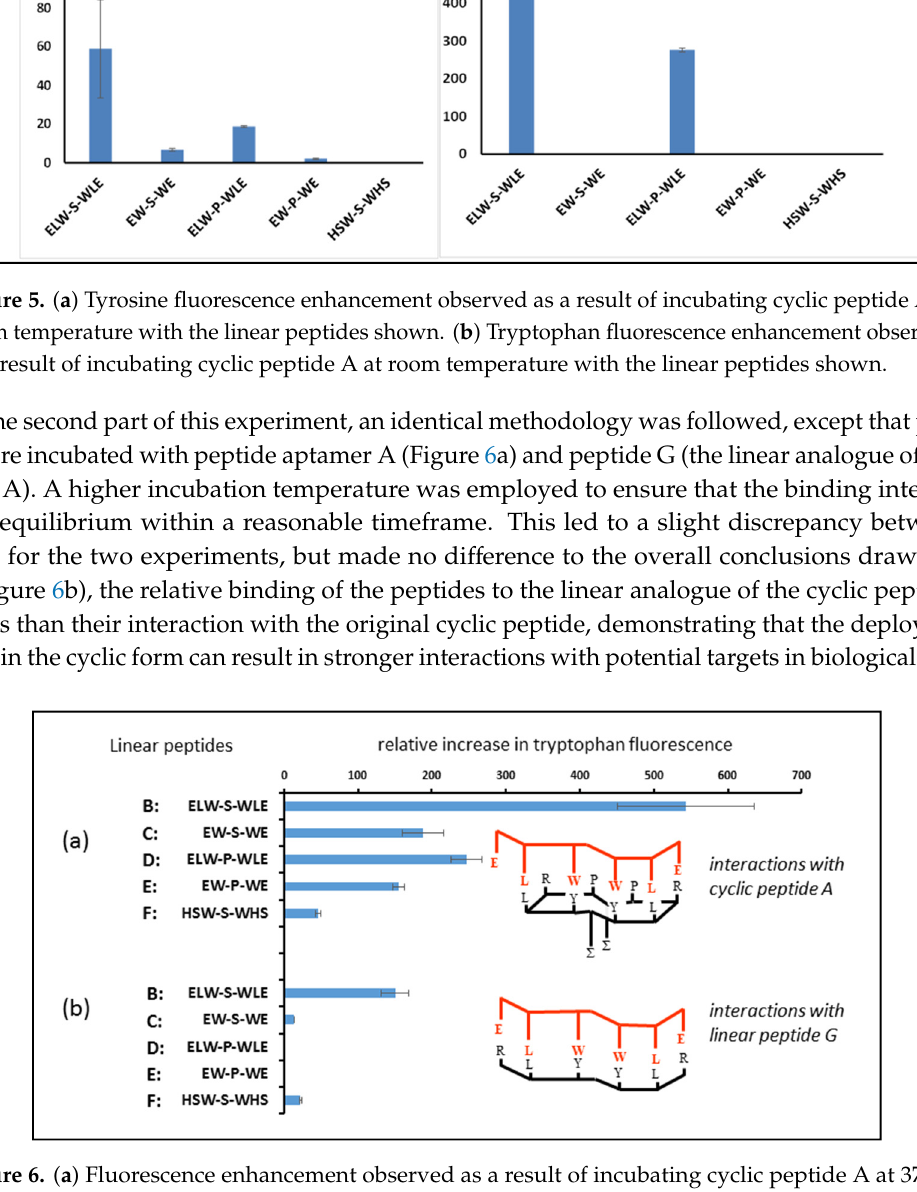
Figure 6. ( a ) Fluorescence enhancement observed as a result of incubating cyclic peptide A at 37 °C with the linear peptides shown. ( b ) Fluorescence enhancement observed as a result of incubating linear peptide G at 37 °C with the linear peptides shown. Tryptophan fluorescence is shown here, since tryptophan is the common feature across the whole series of linear peptides containing tryptophan, and these results are mirrored by the tyrosine readings obtained (data not shown).